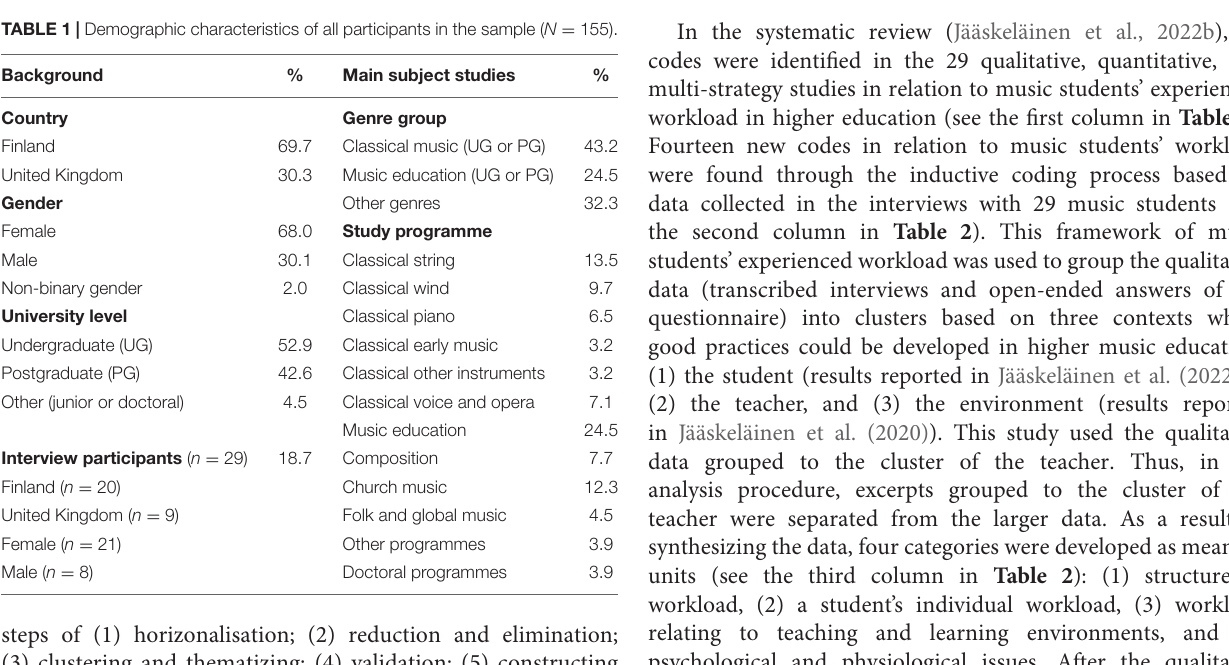
Four categories of different workload meanings drawn from columns 1 and